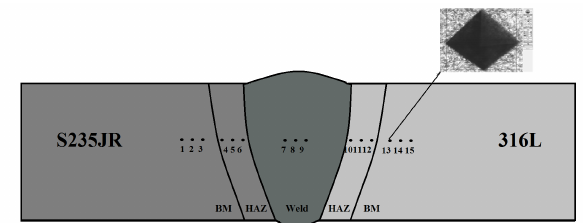
Figure 10: Point distribution of measured hardness test in laser welded dissimilar